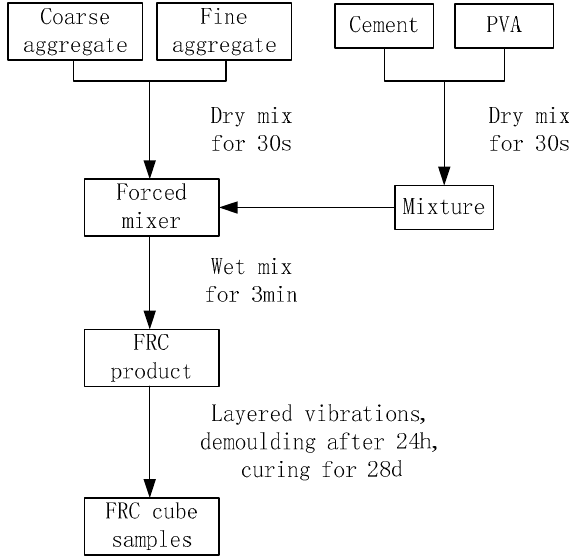
Figure 2. Flow chart for FRC mixing and pouring.